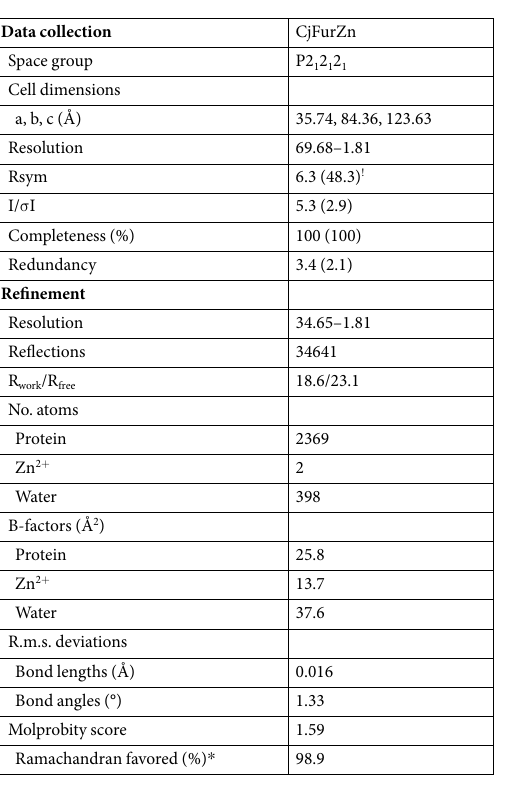
Table 2. Data collection, phasing and refinement statistics for the crystal structure of CjFurZn. ! Highest resolution shell. * There are no Ramachandran